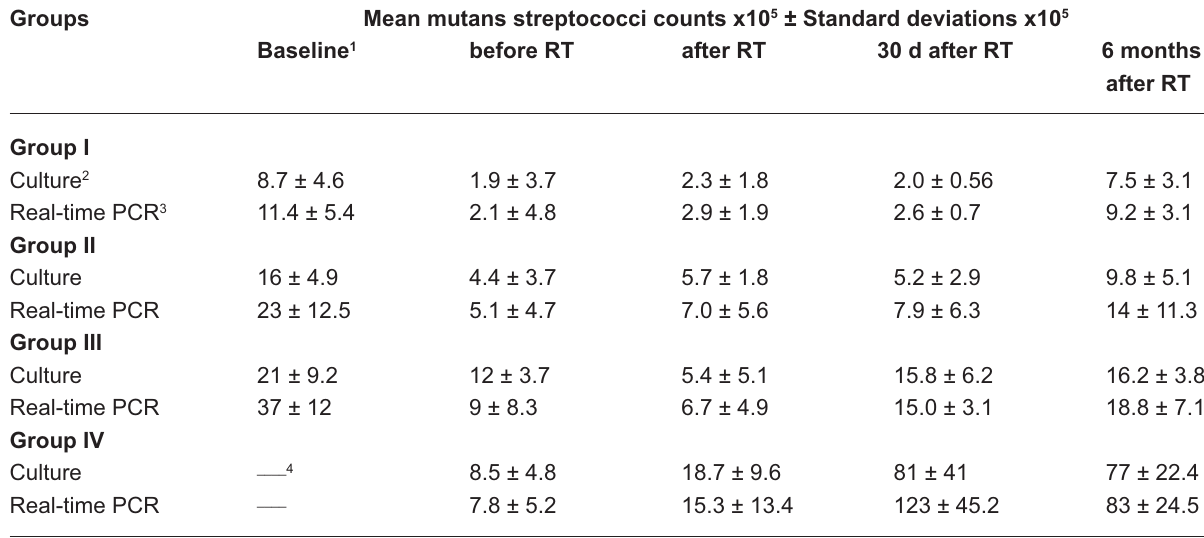
Table 2- Mean counts of mutans streptococci in the experimental groups during the study